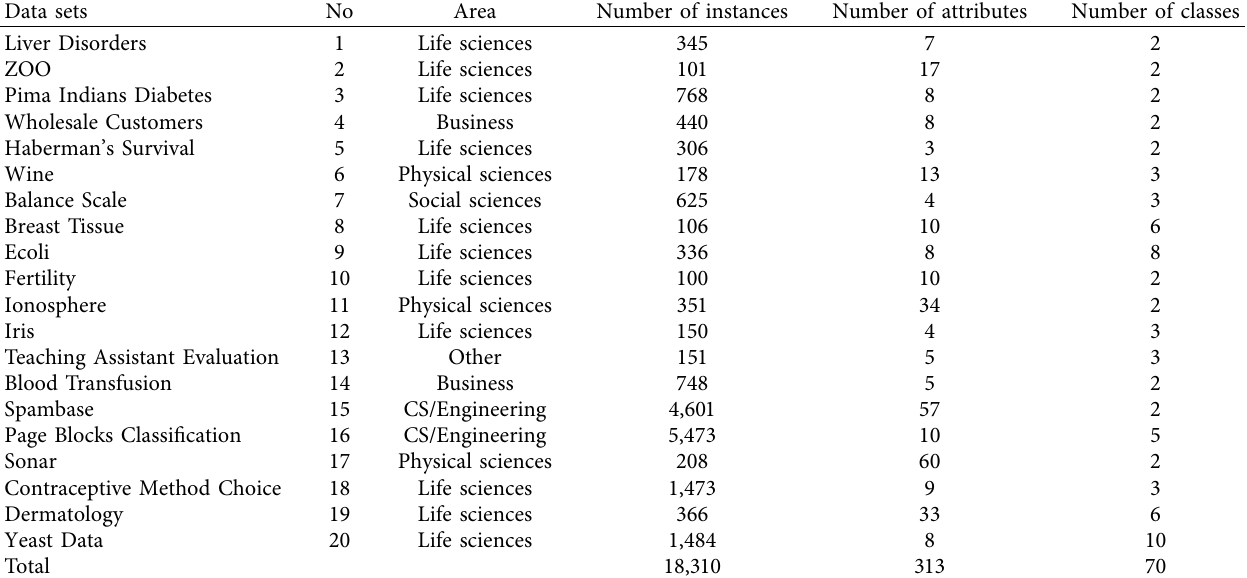
Table 2: Data information of the 20 data